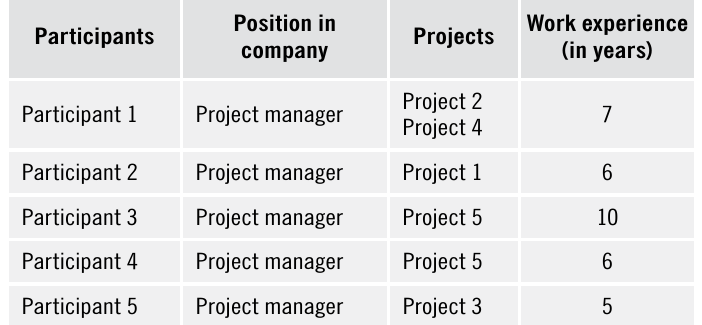
Table 3. Profile of semi-structured interview